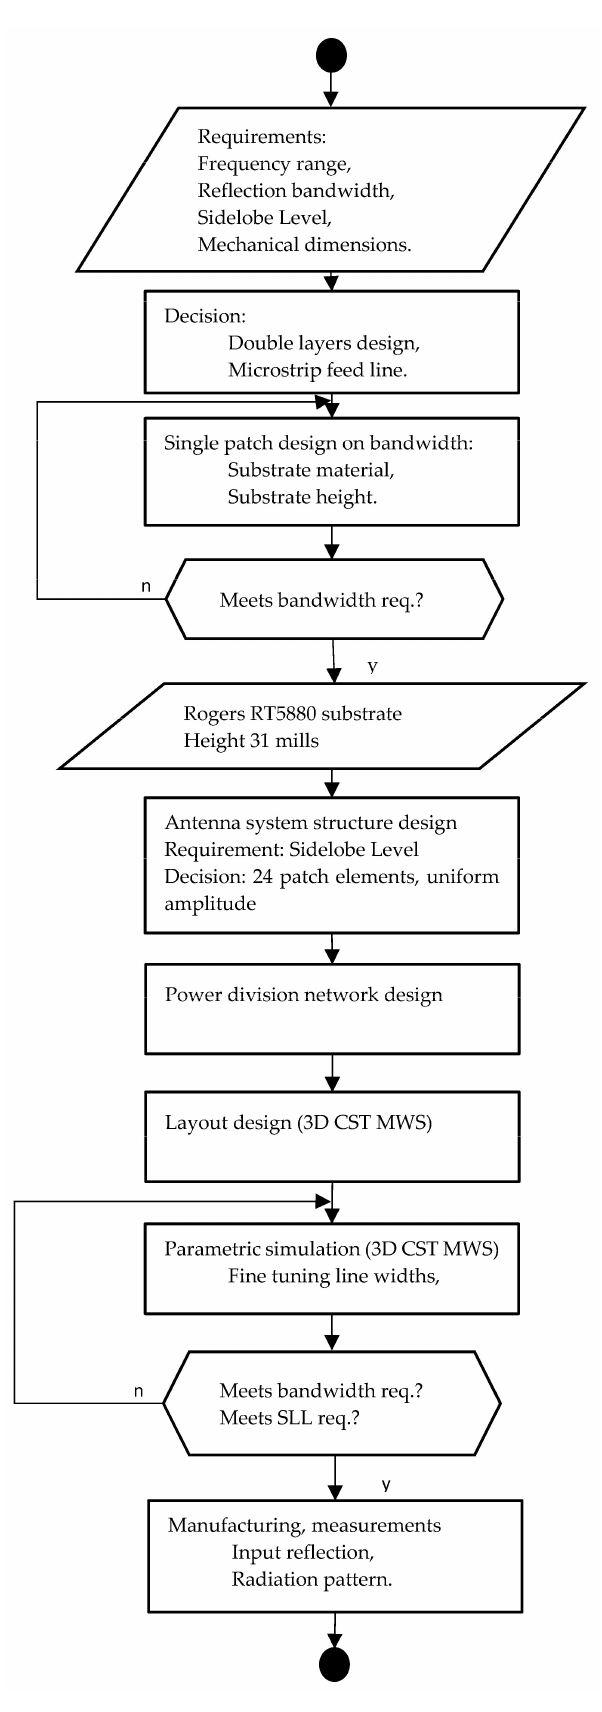
Figure 3. Flowchart of the antenna overall design